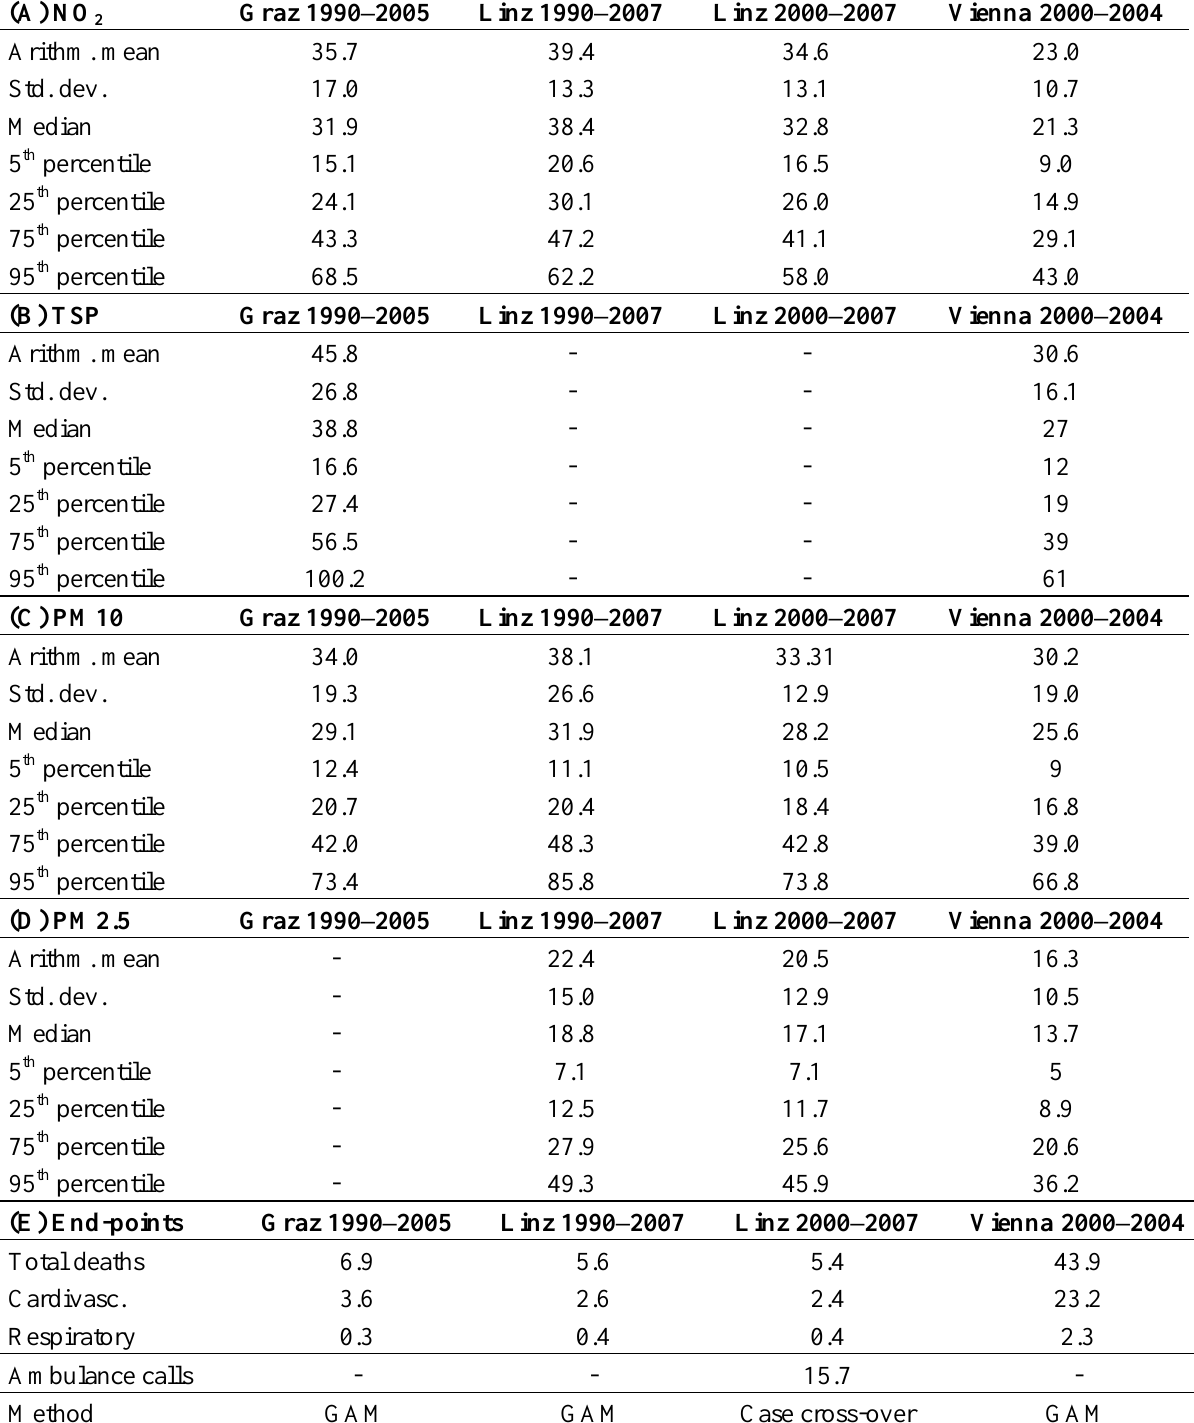
Table 1. Descriptive statistics of pollution concentrations (µg/m³) and health effects (average per